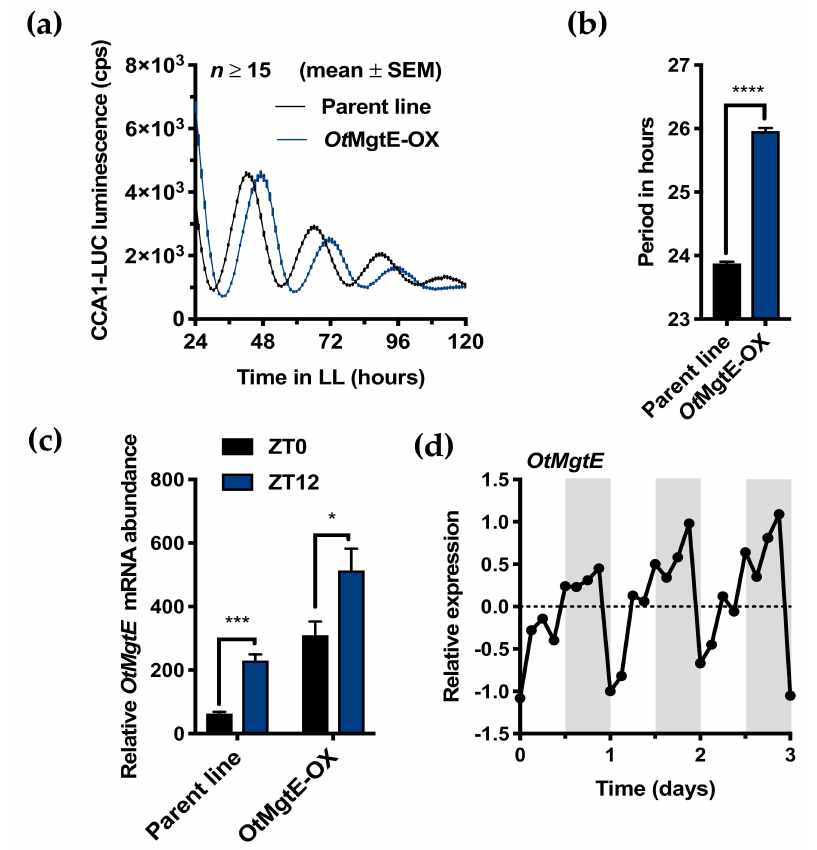
Figure 1. Overexpression of OtMgtE induces a long period phenotype. ( a ) CCA1 bioluminescent traces of Ot MgtE-OX (blue) compared to the parent line (black) in free running conditions (constant light). The graph shows a line through discrete time points, at a ~1-h sampling rate (mean ± Standard Error Mean (SEM)). ( b ) Free-running period inferred from traces in (a), student’s t -test, **** p < 0.0001. ( c ) Relative OtMgtE messenger RNA (mRNA) levels in the parent line compared to Ot MgtE-OX at ZT0 (dawn) and ZT12 (dusk). * = p < 0.05; *** = p < 0.001; student’s t -test. ( d ) Diurnal